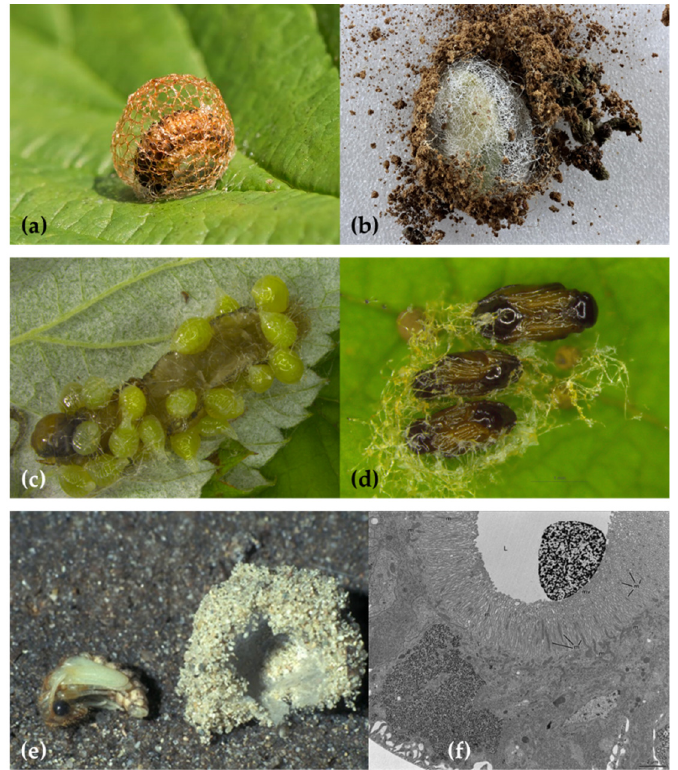
Figure 9. ( a ) Hypera rumicis (Linnaeus, C., 1758) cocoon. Image credit: Charles J. Sharp, CC BY-SA